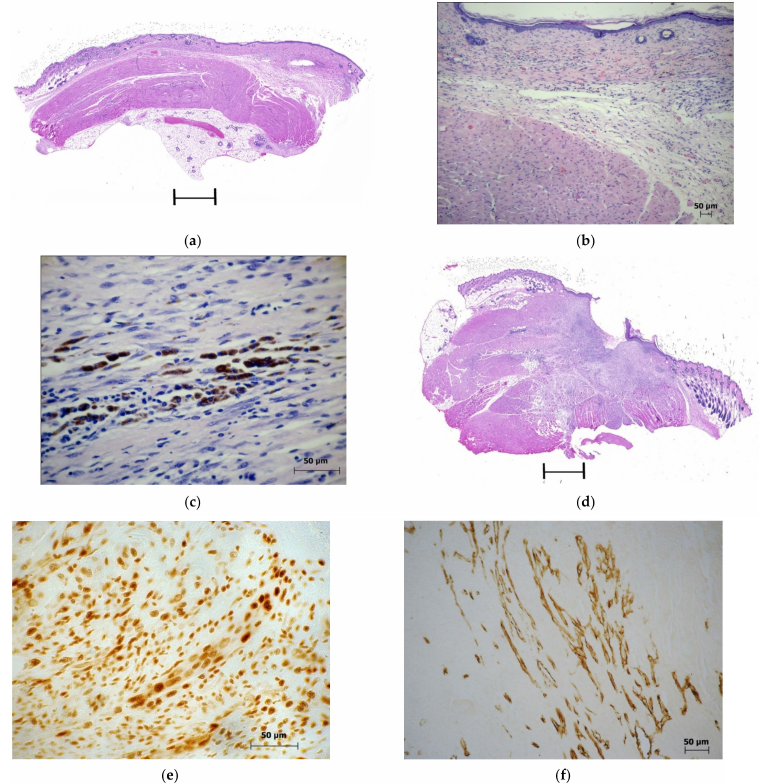
Figure 4. The laser exposure zone on the 21st day after the PDT. Experimental group 1: ( a ) The histological pattern of the zone of the photodynamic impact during scar formation. Staining with hematoxylin and eosin. Scan; ( b ) The epithelial regeneration and proliferation of the connective tissue in the area of the scar. Staining with hematoxylin and eosin. × 10; ( c ) Fragment. A group of melanin-containing macrophages at the site of an eliminated tumor in the zone of photodynamic exposure. Staining with hematoxylin and eosin. × 40; ( d ) The soft tissues of the thigh under the scab. Staining with hematoxylin and eosin. Scan; ( e ) The PCNA-positive nuclei of the regenerated epithelial and the connective tissue cells. Immunohistochemical staining for PCNA. × 40; ( f ) A capillary network in the muscle tissue of the thigh in the PDT zone. Immunohistochemical staining for CD31. ×